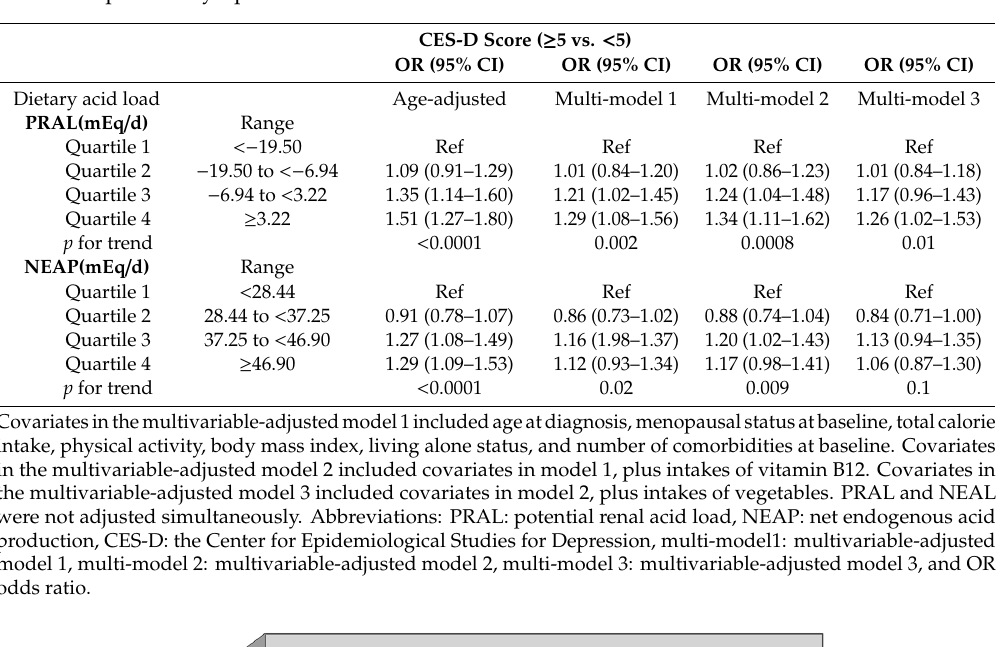
Table 3. Dietary acid load in relation to depression estimated using the CES-D score. CES-D scores ≥ 5 indicate depressive symptoms.